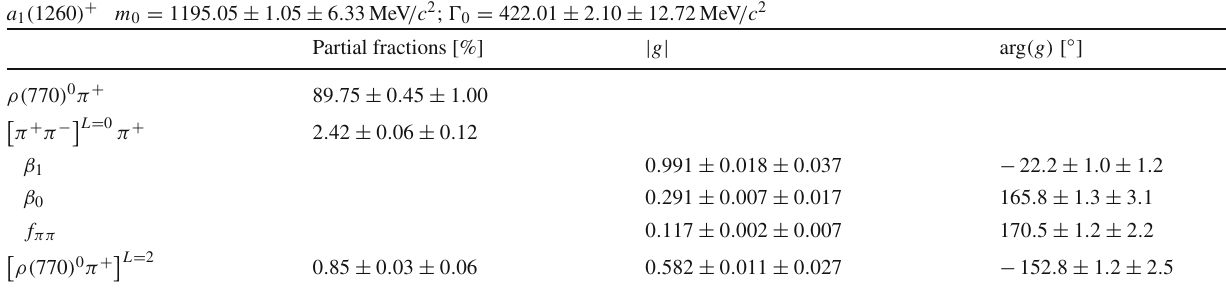
Table 3 Table of fit fractions and coupling parameters for the compo- nent involving the a 1 ( 1260 ) + meson, from the fit performed on the RS decay D 0 → K − π + π + π − . The coupling parameters are defined with